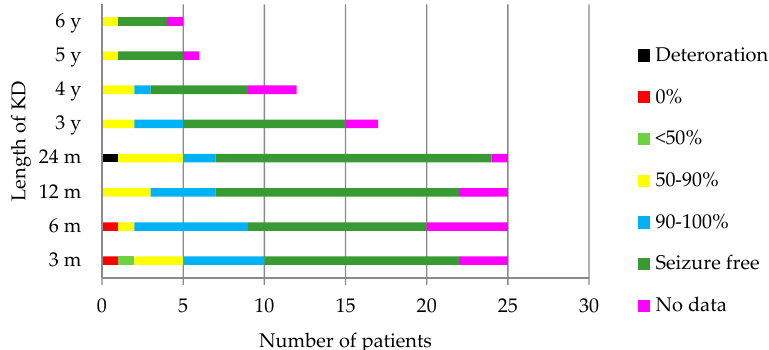
Figure 1. Evolution of the seizures throughout the follow-up. In one patient, the seizures were hard to account for because they happened during sleep. KD: ketogenic diet, m: months, y: years. Table 3. Effectiveness of the diet according to the etiology of epilepsy. The number of patients within each group that were within each improvement category is represented according to the reduction of epileptic seizures compared to baseline.